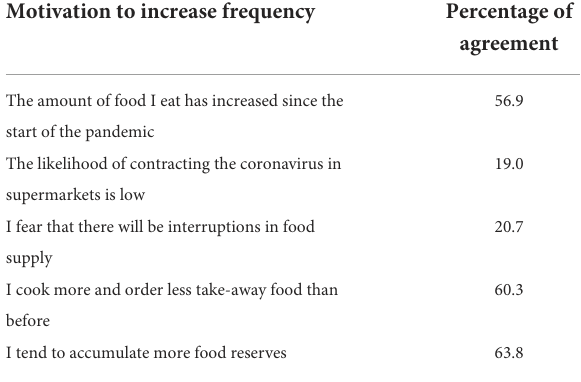
TABLE 3 Summary statistics of the main reasons for increasing purchasing frequency.